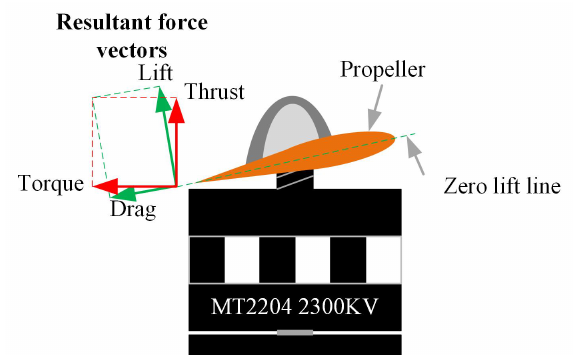
Figure 4. Force vectors produced by the